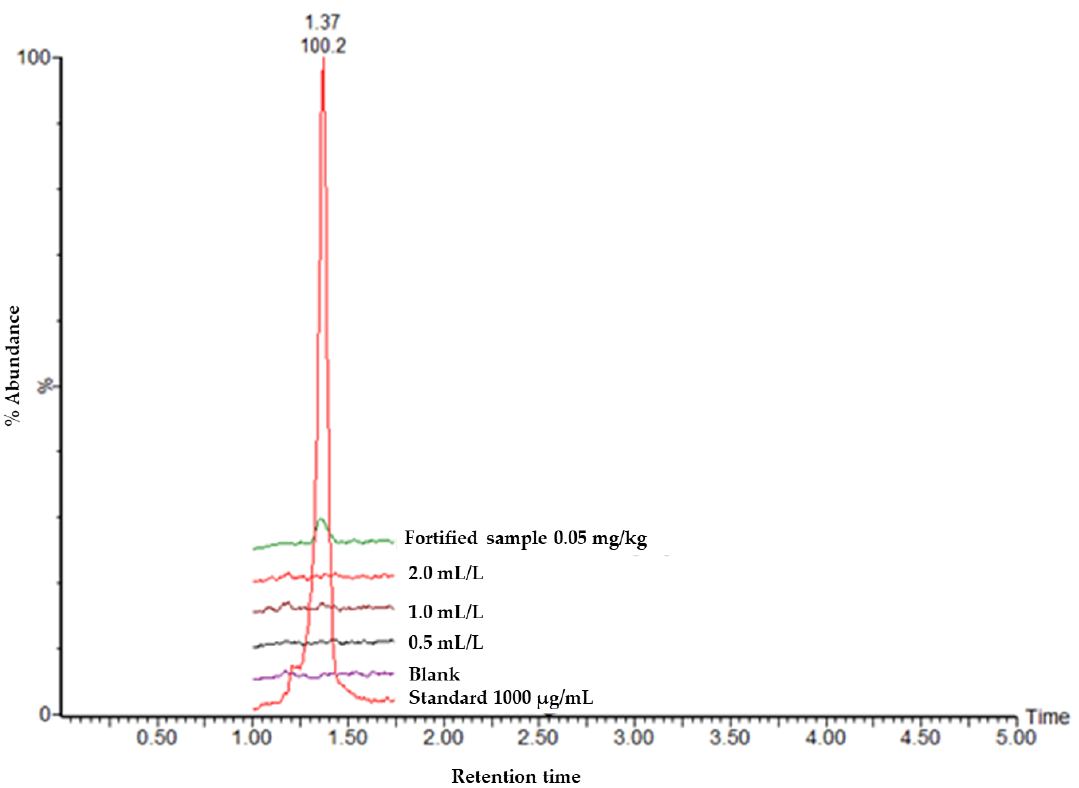
Figure 4. Chromatograms of leaf samples 48 h after two applications of HYM.